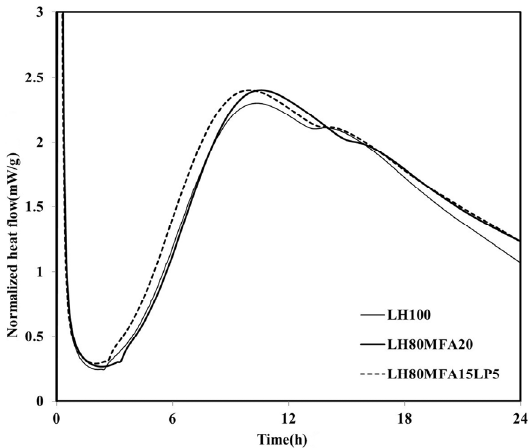
Figure 6. Normalized heat flow of LH80MFA15LP5.